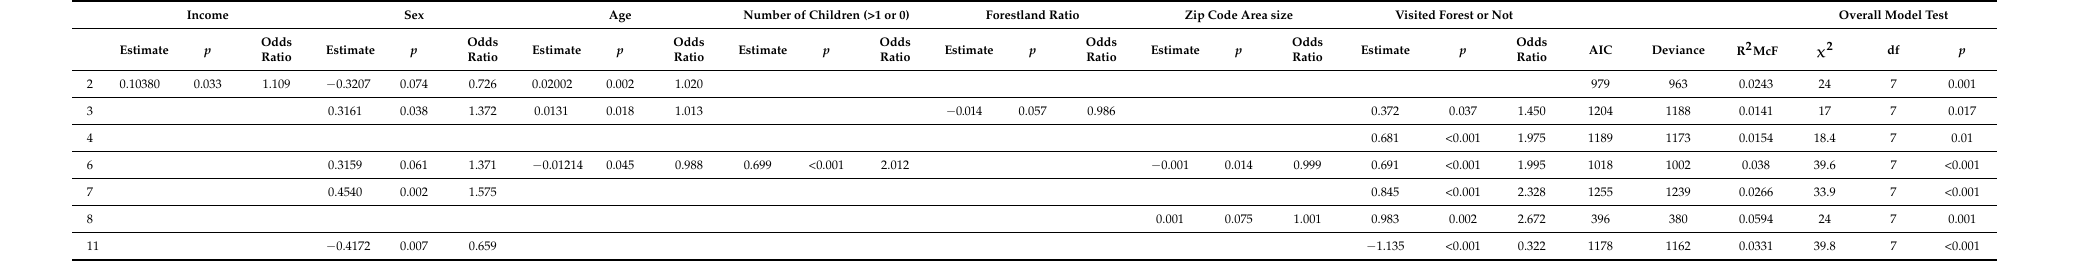
Table 3. Results of logistic regression analysis on the awareness of the functions of forestlands: before the emergency period.